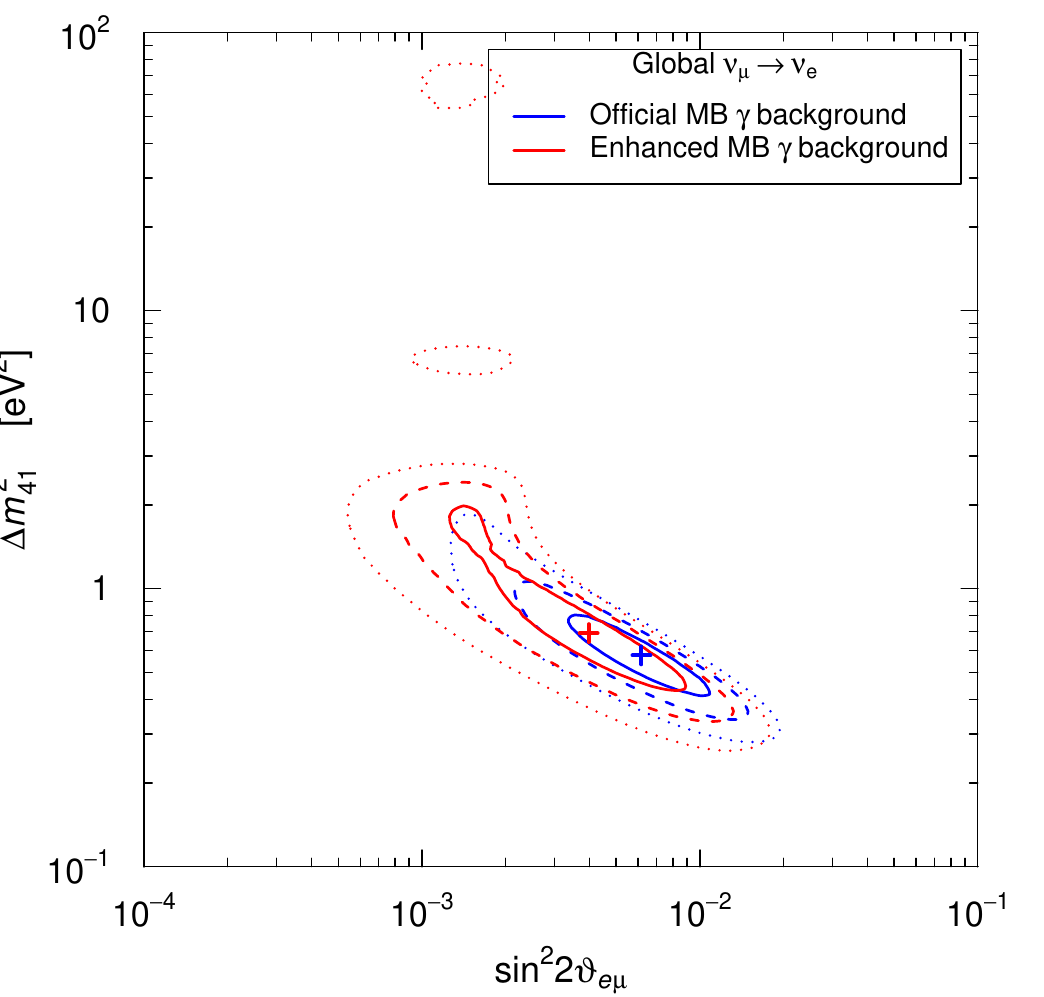
Figure 4 . Contours enclosing 1 σ (solid), 2 σ (dashed), and 3 σ (dotted) allowed regions in the ( sin 2 2 ϑ eµ , ∆ m 2 ) plane obtained from the global analysis of the data of ( − ) ν µ → ( − ) ν e oscillation exper- 41 iments without (blue) and with (red) the enhanced single- γ background in the analysis of Mini- BooNE